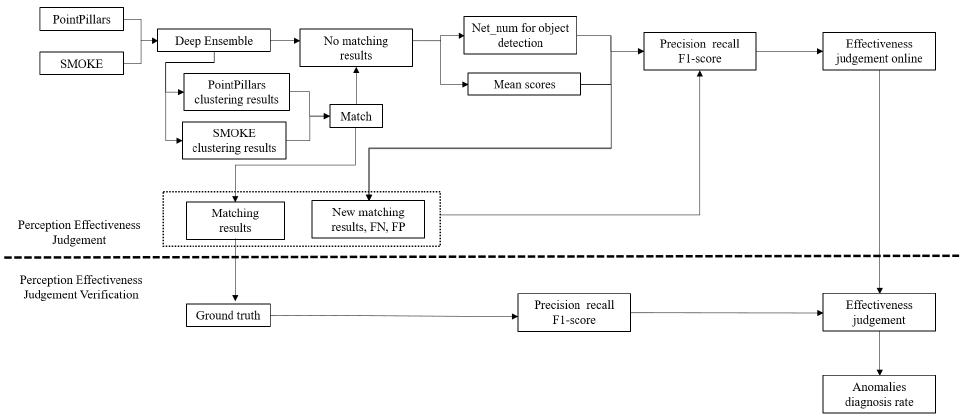
Figure 6. Scheme flow of the perception effectiveness